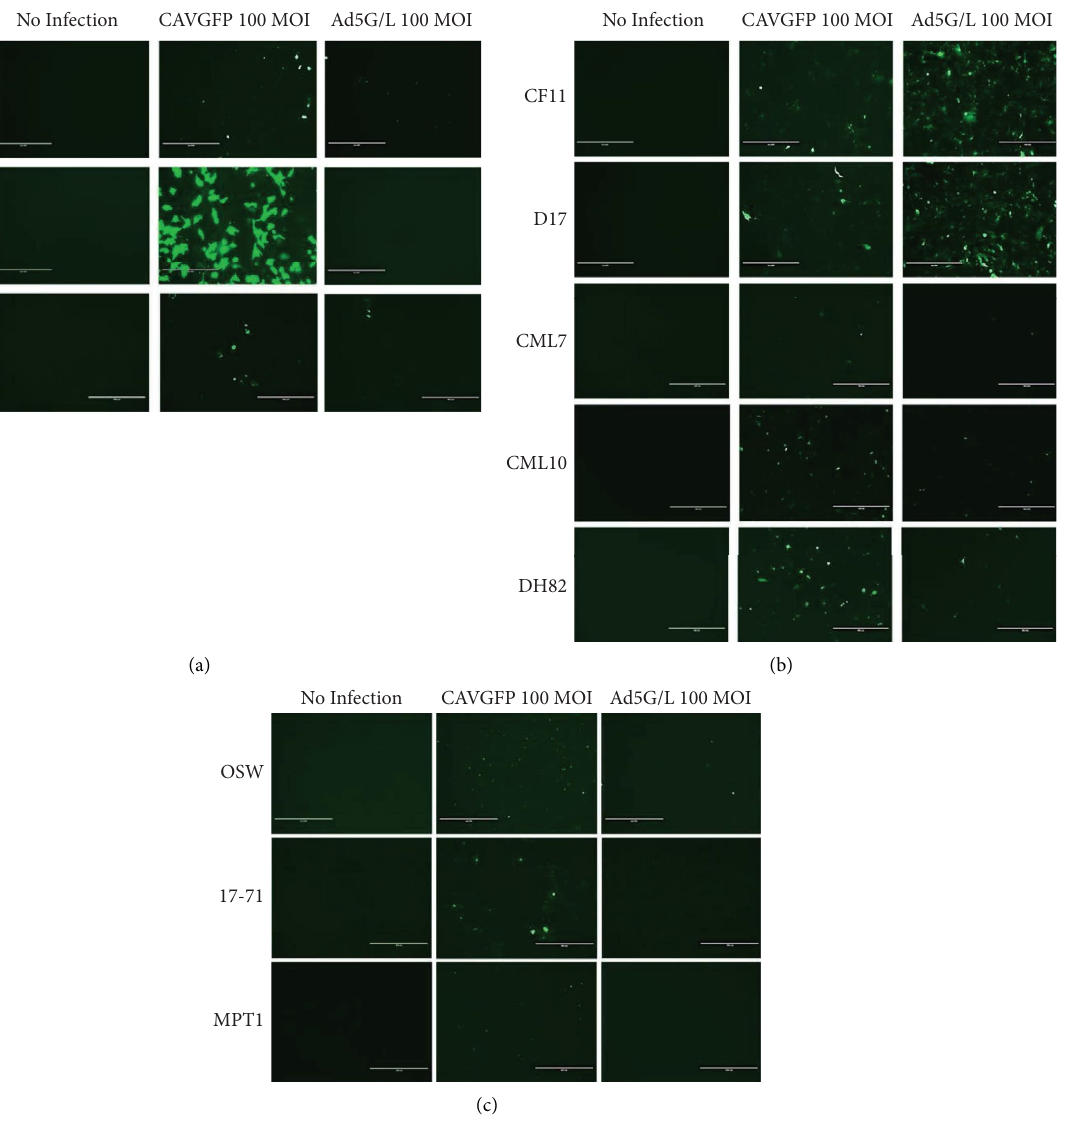
Figure 1: CAVGFP and Ad5G/L directed GFP expression in canine cell Lines. Cells were transduced by adenoviruses CAVGFP and Ad5G/L at 100 multiplicity of infection (MOI 100 virus particles per cell). Cells were monitored at 48 hours post-infection for green fuorescence using an inverted fuorescent microscope (EVOS FL Cell Imaging System). (a) Adherent cell lines, FDK, MDCK, and CMT12, (b) CF11, D17, CML7, CML10, and DH82, and (c) suspended cell lines, OSW, 17–71, and MPT1. Tis fgure is a representative of three independent infection (Figure 5). Te canine cell lines FDK, CMT12, D17, MPT1, and DH82 expressed CAR at moderate to high levels. Te